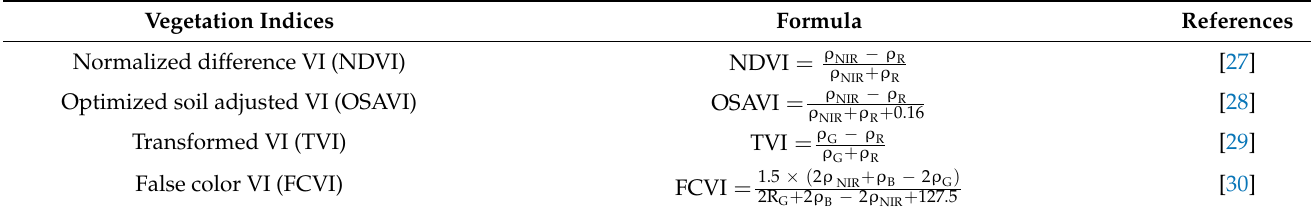
Table 3. The formulas for VIs were used in this